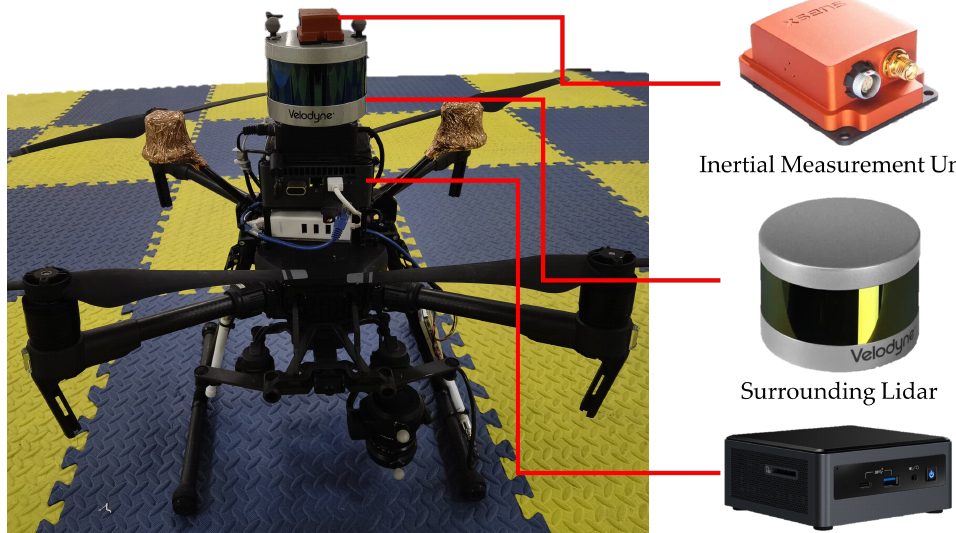
Figure 6. The equipment of the experimental